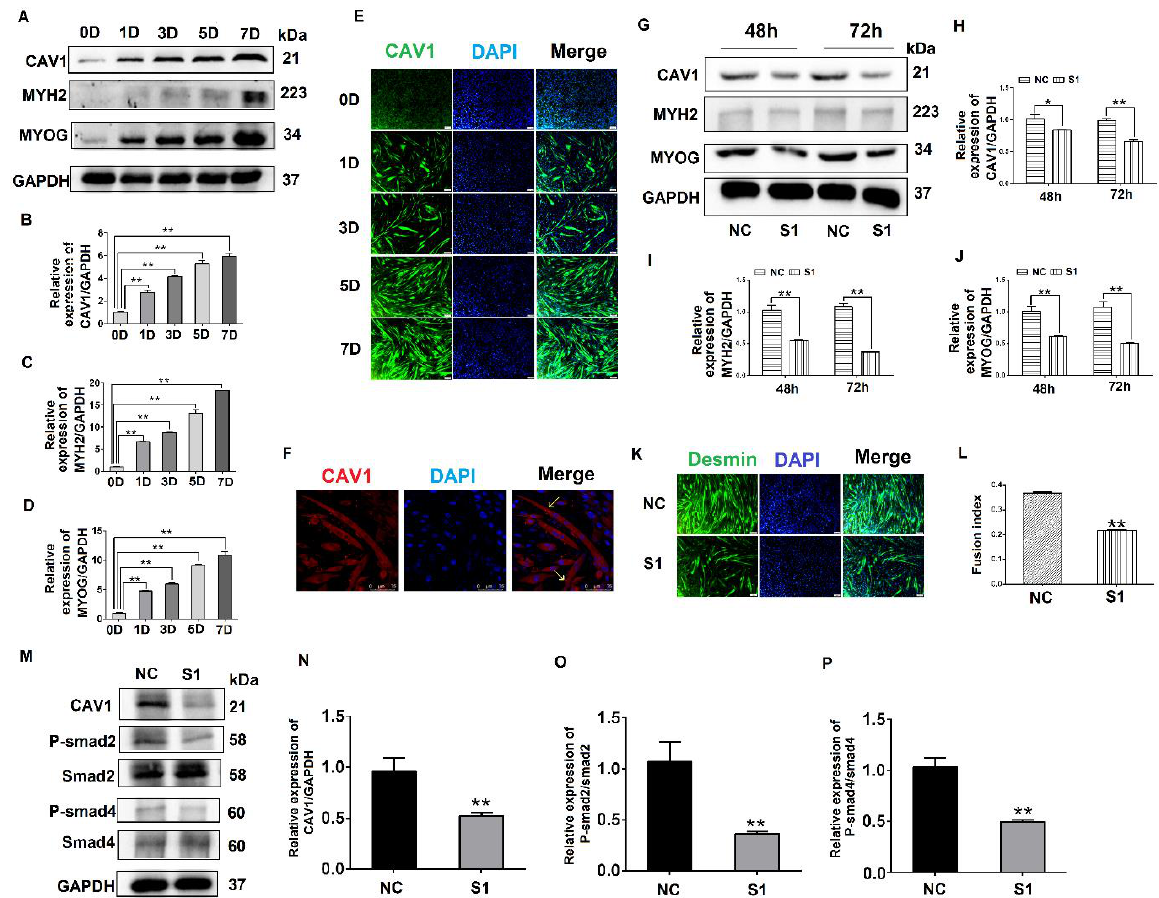
Figure 4. Effects of CAV1 on C2C12 cell differentiation. ( A ). Change in CAV1, MYH2, and MYOG expression levels at different stages of C2C12 cell differentiation. ( B ). Grayscale scan of CAV1 in Figure A. ( C ). Grayscale scan of MYH2 in Figure A. ( D ). Grayscale scan of MYOG in Figure A. ( E ). Immunofluorescence was used to measure the changes in CAV1 expression levels and the morphology of myotubes at various stages of C2C12 differentiation. CAV1 was labeled green using FITC and the nucleus blue using DAPI. ( F ). Laser confocal microscopy demonstrating the location of CAV1 expression, stained red using RBFITC, and nuclei blue using DAPI. ( G ). Changes in CAV1, MYH2, and MYOG expression levels after siRNA transfection for 48 h and 72 h. ( H ). Grayscale scan of CAV1 in Figure G. ( I ). Grayscale scan of MYH2 in Figure G. ( J ). Grayscale scan of MYOG in Figure G. ( K ). Changes in the fusion rate of C2C12 cells in mice after CAV1 inhibition by immunofluorescence detection. ( L ). Myotubule fusion rate in Figure K. ( M ). Change in CAV1, P-Smad2, and P-Smad4 expression after siRNA fragment S1 transfection of CAV1. ( N ). Grayscale scan of CAV1 in Figure M. ( O ). Grayscale scan of P-Smad2 in Figure M. ( P ). Grayscale scan of P-Smad4 in Figure M. (** p values < 0.01, * p values < 0.05) ( n = 3).